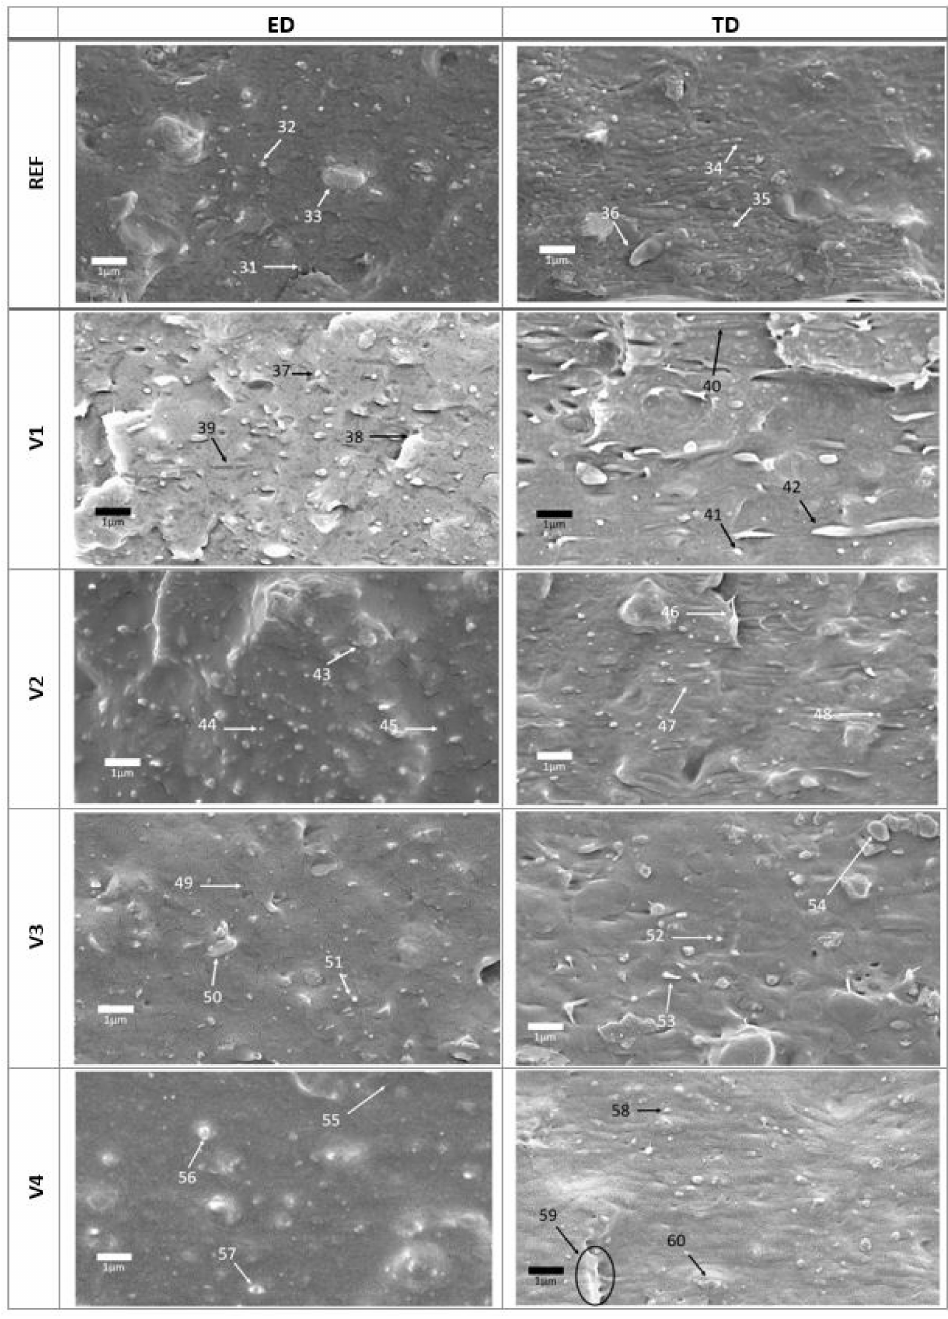
Figure 4. Detailed (magnification of 10,000) SEM of fracture surfaces of unmodified PBAT/PLA (REF) and CECL-modified ( V1 to V4 ) films in ED and TD blown film extrusion